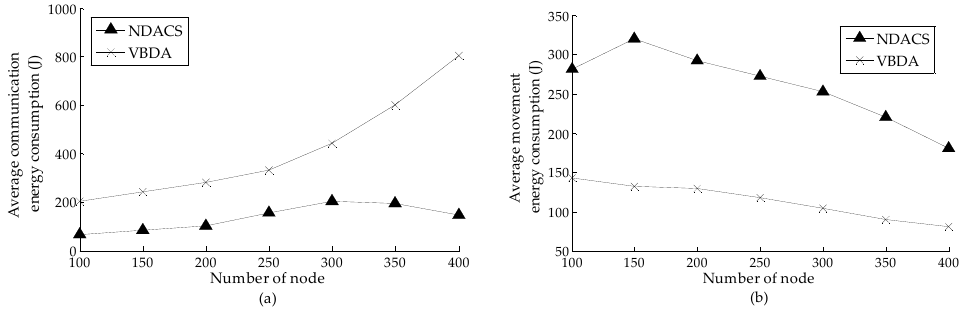
Figure 11. Comparison of energy consumption between NDACS and VBDA: ( a ) comparison of node average energy consumption of communication between NDACS and VBDA varying with the number of nodes, and the initial communication radius is 60 m; ( b ) comparison of node average energy consumption of movement between NDACS and VBDA varying with the number of nodes.